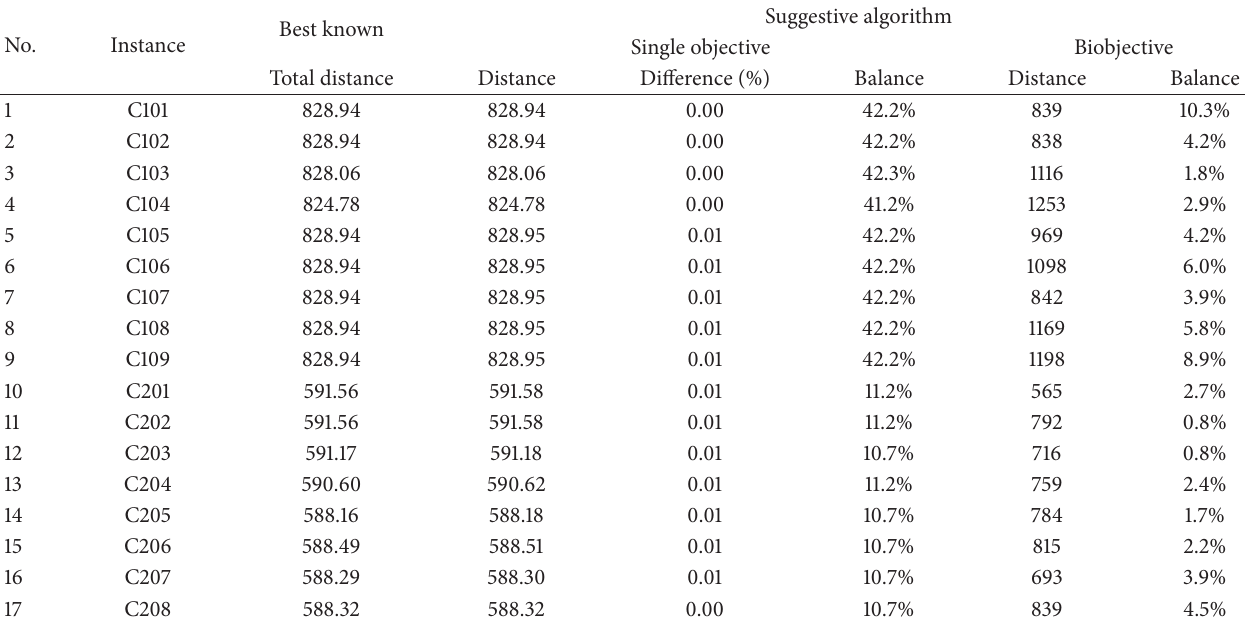
Table 1: Results of C instances.